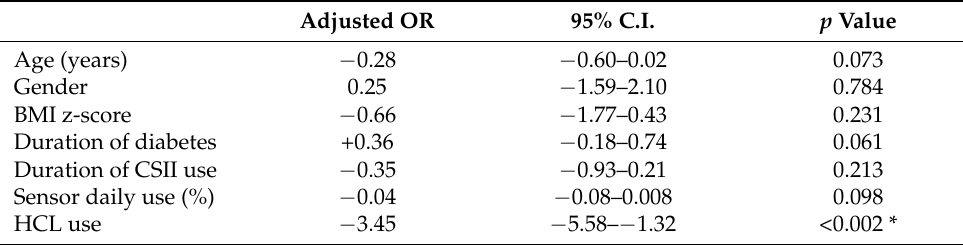
Table 3. Results of multivariate logistic regression models for